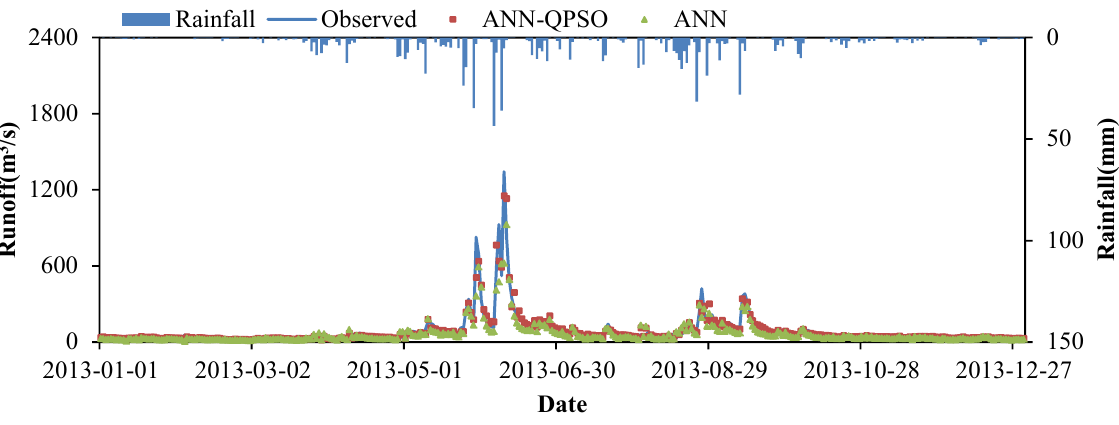
Figure 9. ANN, ANN-quantum-behaved particle swarm optimization (QPSO) forecasted data and observed runoff data during testing